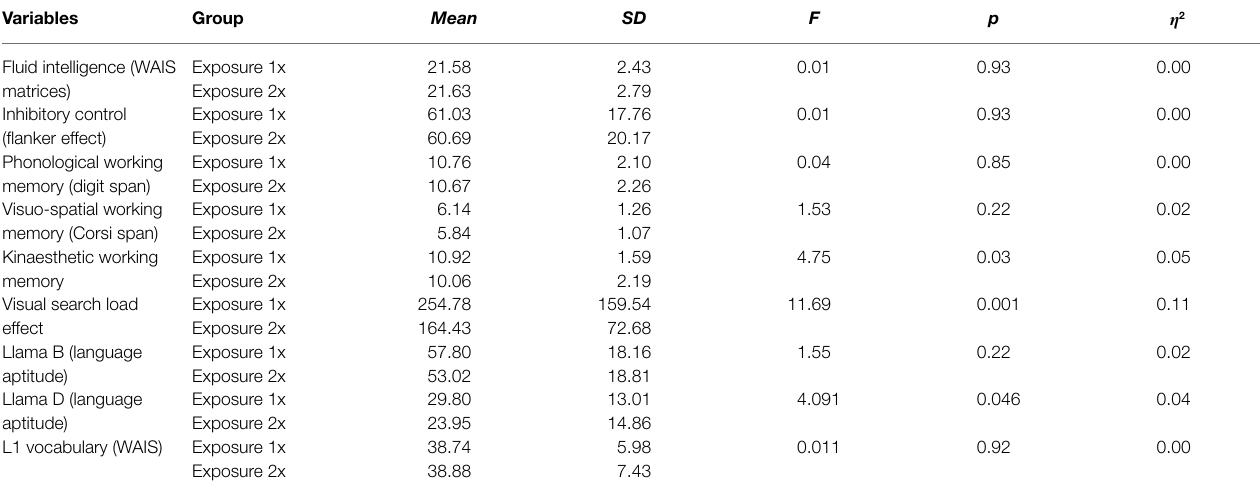
TABLE 2 | Cognitive background variables by exposure